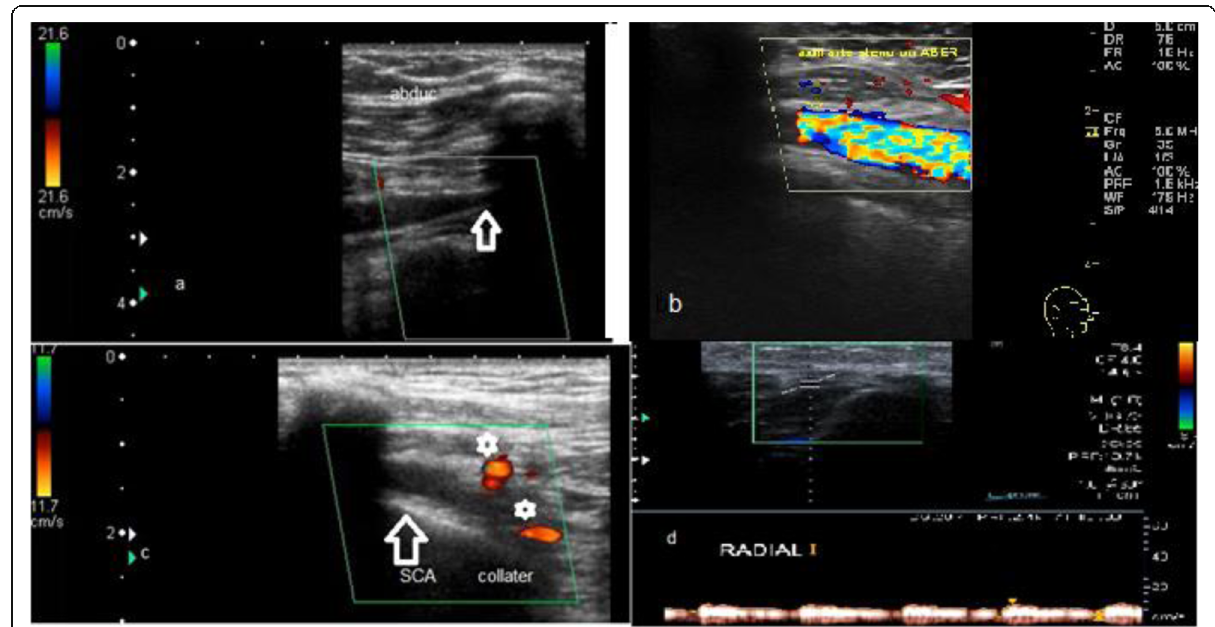
Fig. 4 a Color image of the axillary-subclavian artery junction showing tapered significant narrowing of the artery on arm abduction with a peaking of the artery toward the costo-clavicular space (white open arrow). Note the flow cessation in the examined artery. b Color image for the same arterial segment in another patient showing marked color aliasing due to high-velocity jet of the arterial stenosis at the outlet of the costo- clavicular space. c Color Doppler image showing complete cessation of the arterial flow on arm abduction (open white arrow) and the presence of regional arterial collaterals (white asterisks) circumventing the obstruction. d Spectral Doppler image showing tardus parvus waveform that was interrogated in the distal radial artery on arm abduction. This was correlated clinically with an obliterated or a weak radial